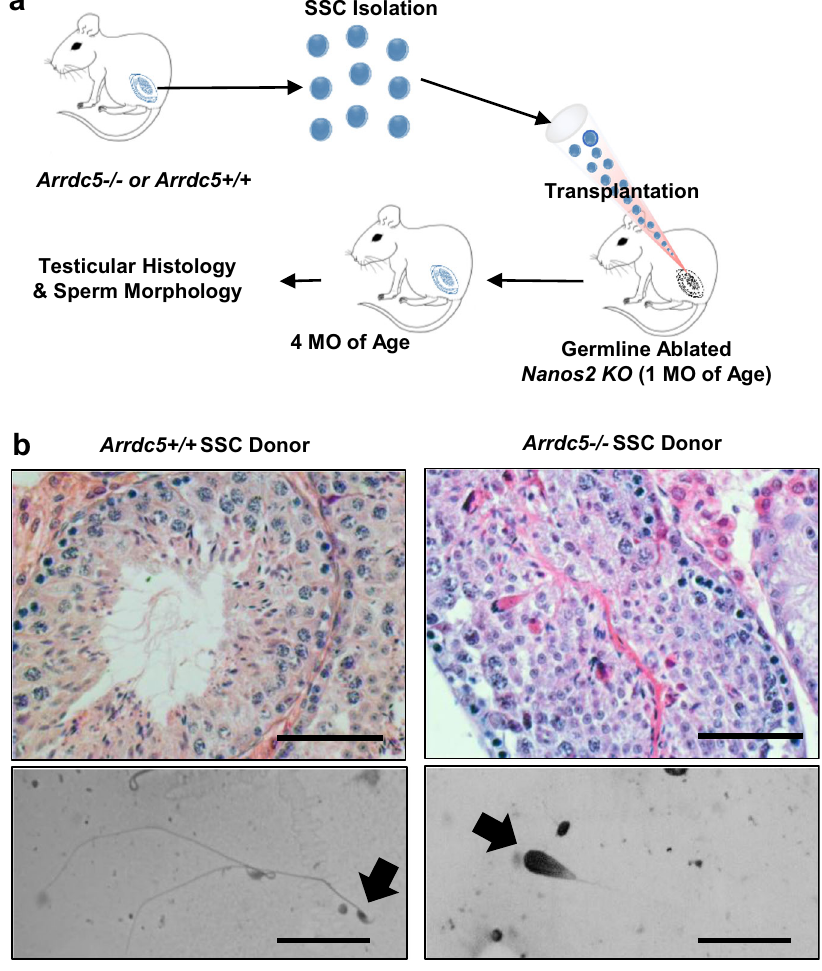
Fig. 8 | Assessment ofgerm cell-intrinsic defects of Arrdc5 − / − mice.a Schematic of experimental strategy to assess whether defects in spermiogenesis are intrinsic to germ cells of Arrdc5 − / − mice. b Seminiferous tubule cross-sections from testes (upper panel) and epididymal fl ushing (lower panel) of recipient mice 3 months after transplantation with spermatogonial stem cells from adult Arrdc5 + /+ or Arrdc5 − / − littermates. Normal spermatogenesis was observed for recipient males